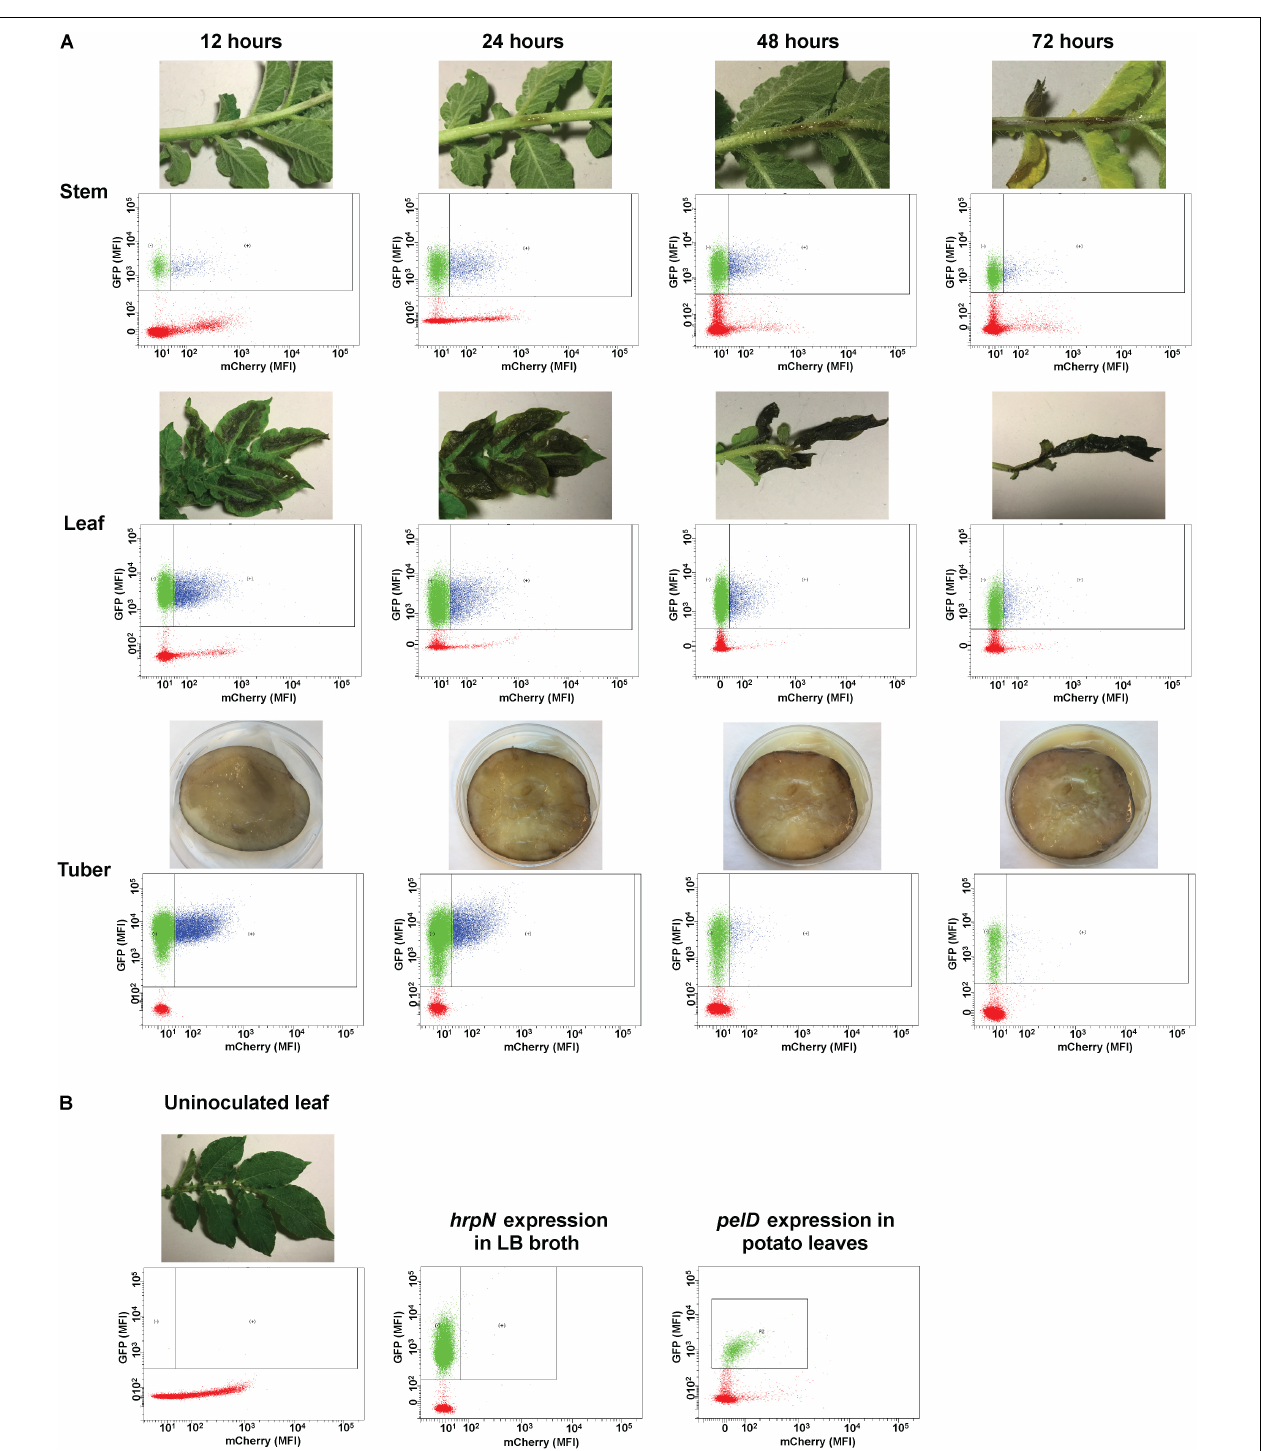
FIGURE 3 | Flow cytometry examination of hrpN expression in D. dadantii at different stages of infection in potato stem, leaf, and tuber. (A) Potato stem, leaf, and tuber infected with D. dadantii ( nptII-gfp-hrpN-mCherry ), examined at 12, 24, 48, and 72 h post-inoculation by flow cytometry. Disease symptoms (top) and matrix of red florescence ( x -axis) – green fluorescence ( y -axis) determined by flow cytometry (bottom) are displayed. Red dots: plant debris that are GFP negative. Green dots: GFP positive bacteria with low level of hrpN expression (mCherry negative). Blue dots: GFP positive bacteria with high level of hrpN expression (mCherry positive). (B) Flow cytometry measurement of green and red fluorescence of un-inoculated potato leaves, a LB culture of D. dadantii ( nptII-gfp-hrpN-mCherry ), and potato leaves infected by D. dadantii ( nptII-gfp-pelD-mCherry ).